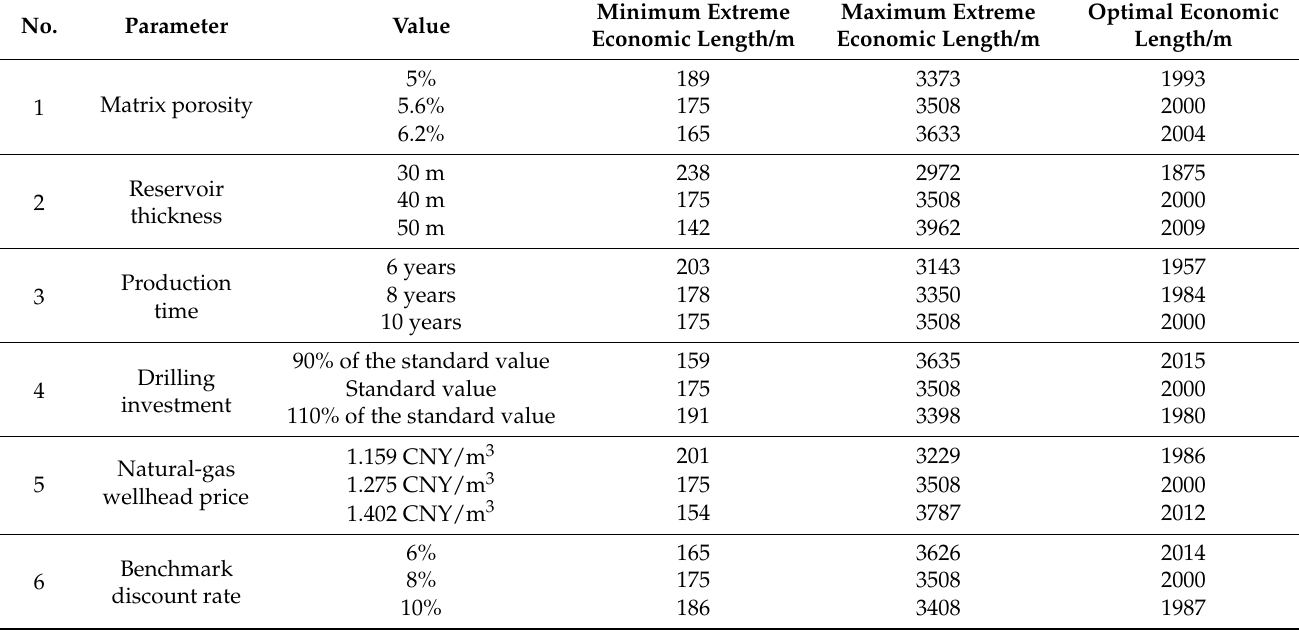
Table 5. Economic lateral length of the horizontal well with six changing